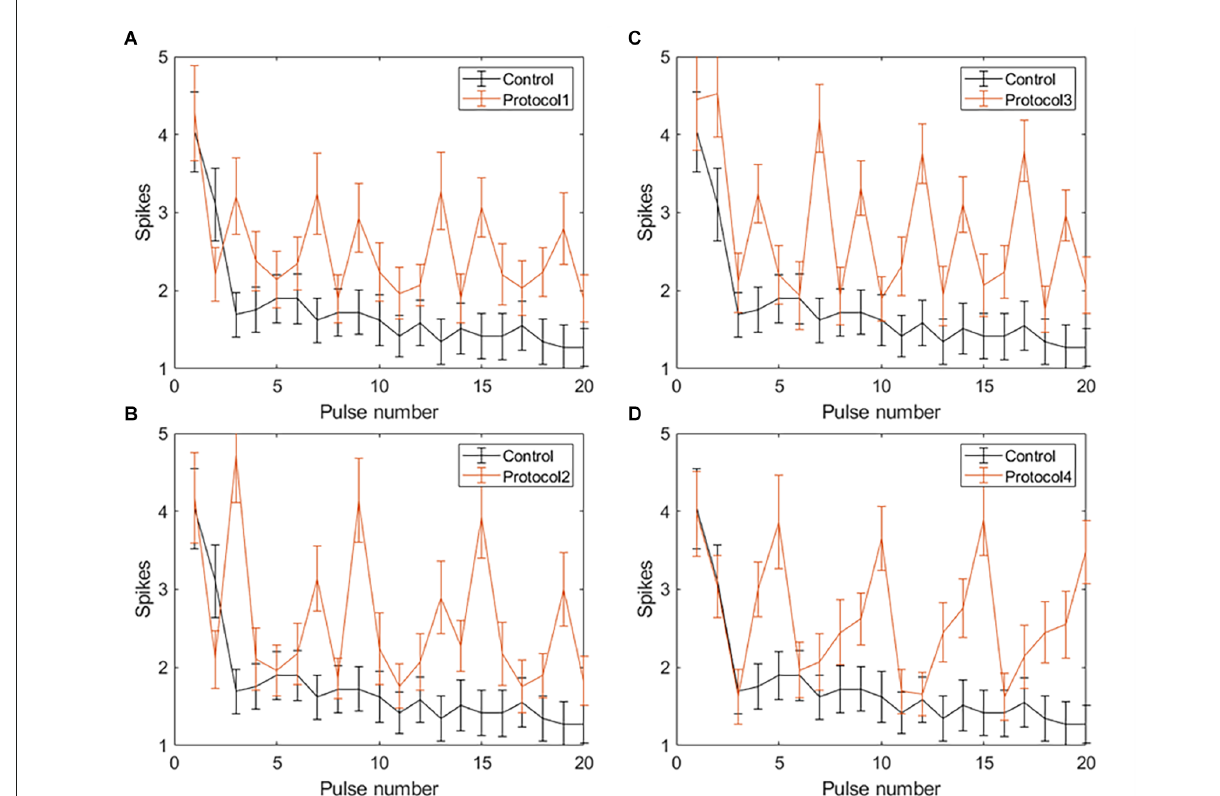
FIGURE7 Spiking activity of RGCs in response to VPCE pulse trains and control pulse train at 20 Hz. The number of evoked spikes counted in 50 ms bins after the onset of each pulse is plotted against the pulse number ( n = 29). The pulse sequences in Table 1 , Supplementary Tables S1, S2, and S3 are repeated to create a train of 20 pulses. Spiking activity in response to (A) Protocol 1: pulse width varies and charge per phase is kept constant. (B) Protocol 2: pulse width varies and charge per phase is calculated based on strength-duration curve. (C) Protocol 3: all pulse parameters vary and the charge per phase is kept constant. (D) Protocol 4: all pulse parameters vary and charge per phase is calculated based on strength-duration